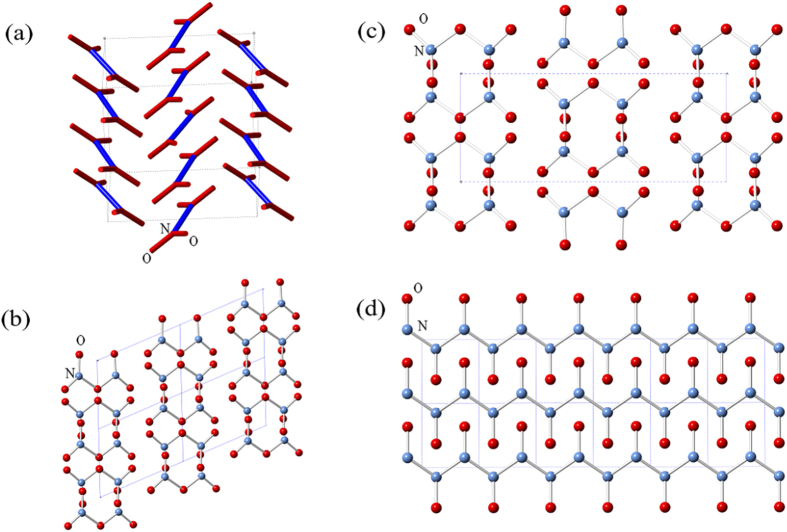
Structures of (a) P21/c NO2, (b) P-1 and (c) C2/c N2O5, (d) P21/m NO.